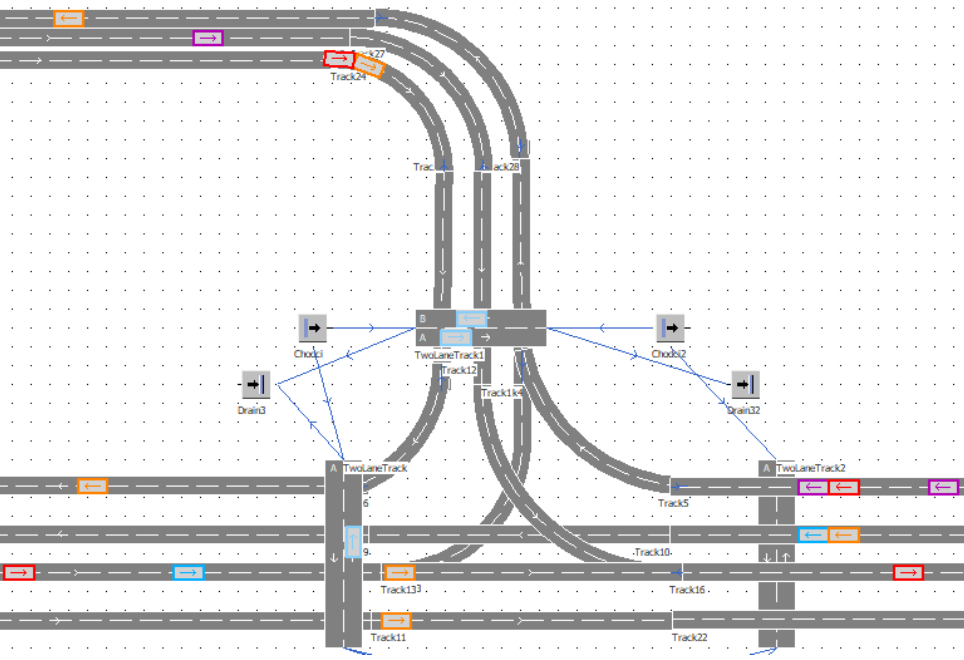
Figure 7. Vector representation of the transporters.